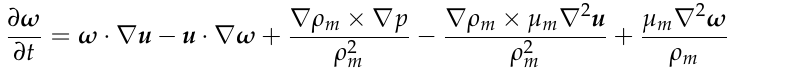
The left-hand side of Equation (11) represents the growth rate of the vorticity. The first term in the right-hand side of Equation (11) is the tensile distortion term. The second term is the expansion and contraction term. The third term is the baroclinic moment term, and the last two terms are viscous dissipation terms. The stretch distortion term could cause the stretching and deformation of vortical structures due to the velocity gradient. The expansion and contraction term may reflect the impacts of the expansion or contraction of fluid on the vorticity. The baroclinic moment term is mainly caused by the non-parallelism between pressure and gradient. The viscous dissipation terms refer to the gradual dissipation of vorticity due to fluid viscosity. As the calculation model in this paper is two-dimensional, the first term in the right-hand side of Equation (11) equals zero. The expansion contraction term is an important vorticity source in cavitation flows because it is proportional to the interphase mass-transport velocity [34]. Moreover, the density gradient of the mixture and the pressure gradient in the cavitation flow are not always parallel to each other [35], so the baroclinic moment term also could cause the increase of vorticity. Figure 8 shows the distributions of the vapor phase volume fraction, the vortex expansion and contraction term distribution, the baroclinic moment term and the vortex viscosity dissipation term. It could be observed that the areas of the expansion and contraction term are larger than the other two terms. The baroclinic moment term mainly focuses on the vapor-liquid interface and plays a mass-transfer role. The baroclinic moment term is very important for the vorticity generation with cavitation. The viscous dissipation terms mainly distribute at the interface between the vapor and liquid because phases